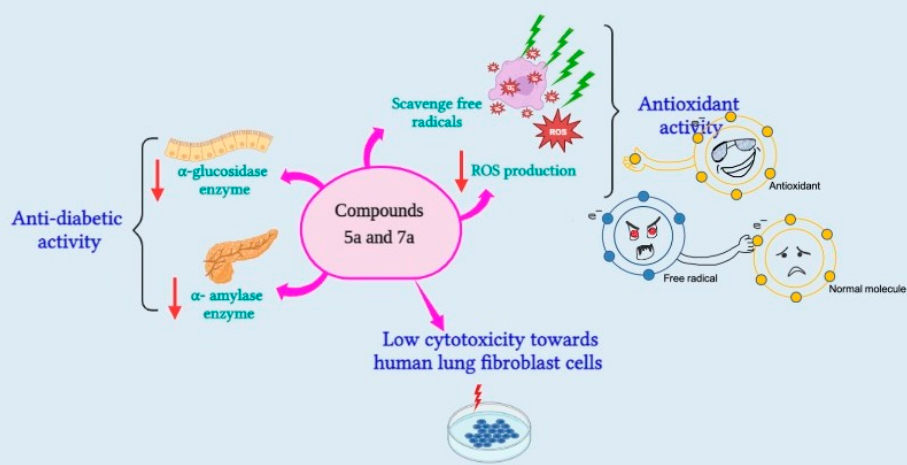
Figure 8. Illustration of the antidiabetic action of compounds 5a and 7a